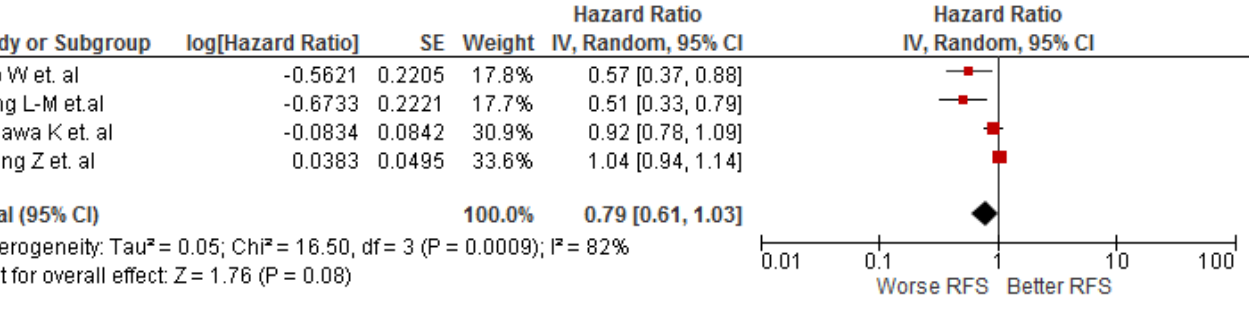
Figure 3. Association of LMR and DFS in patients with cholangiocarcinoma.